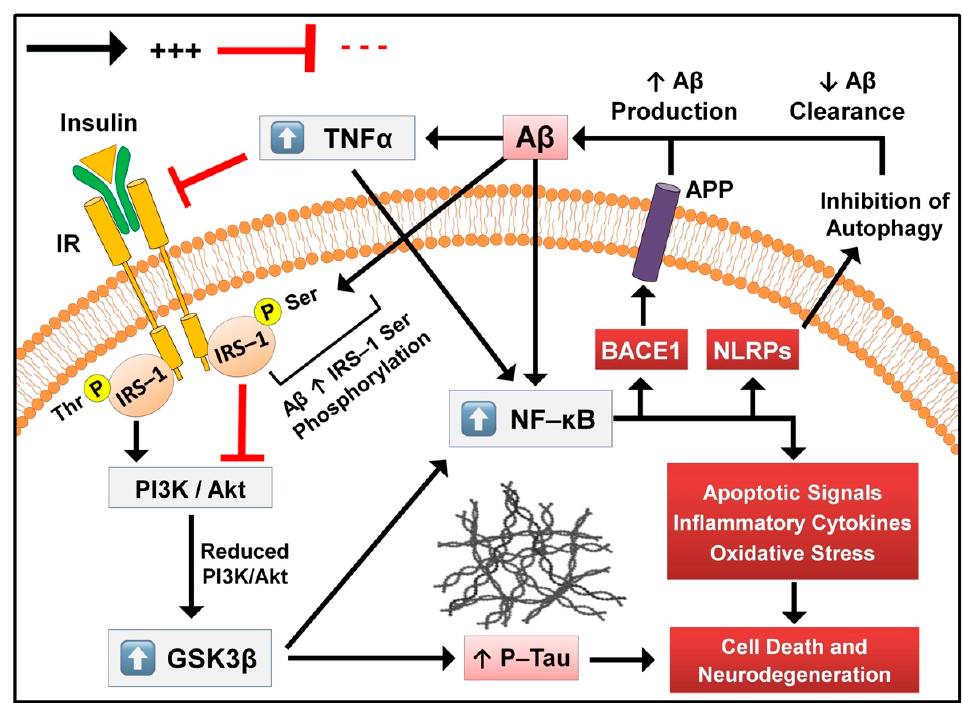
Figure 2. Schematic representation of some defective signaling pathways involved in the pathogenesis and progression of AD.